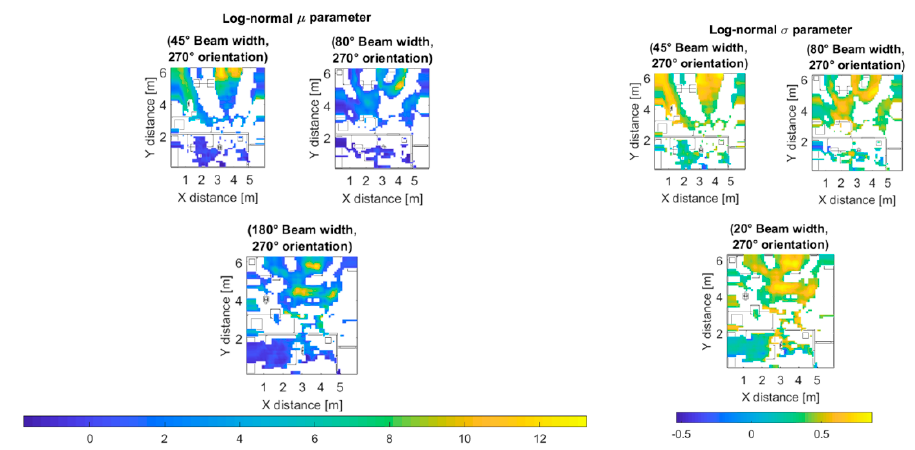
Figure 16. Log-normal distribution’s µ ( left ) and σ ( right ) parameters for the indoor scenario.